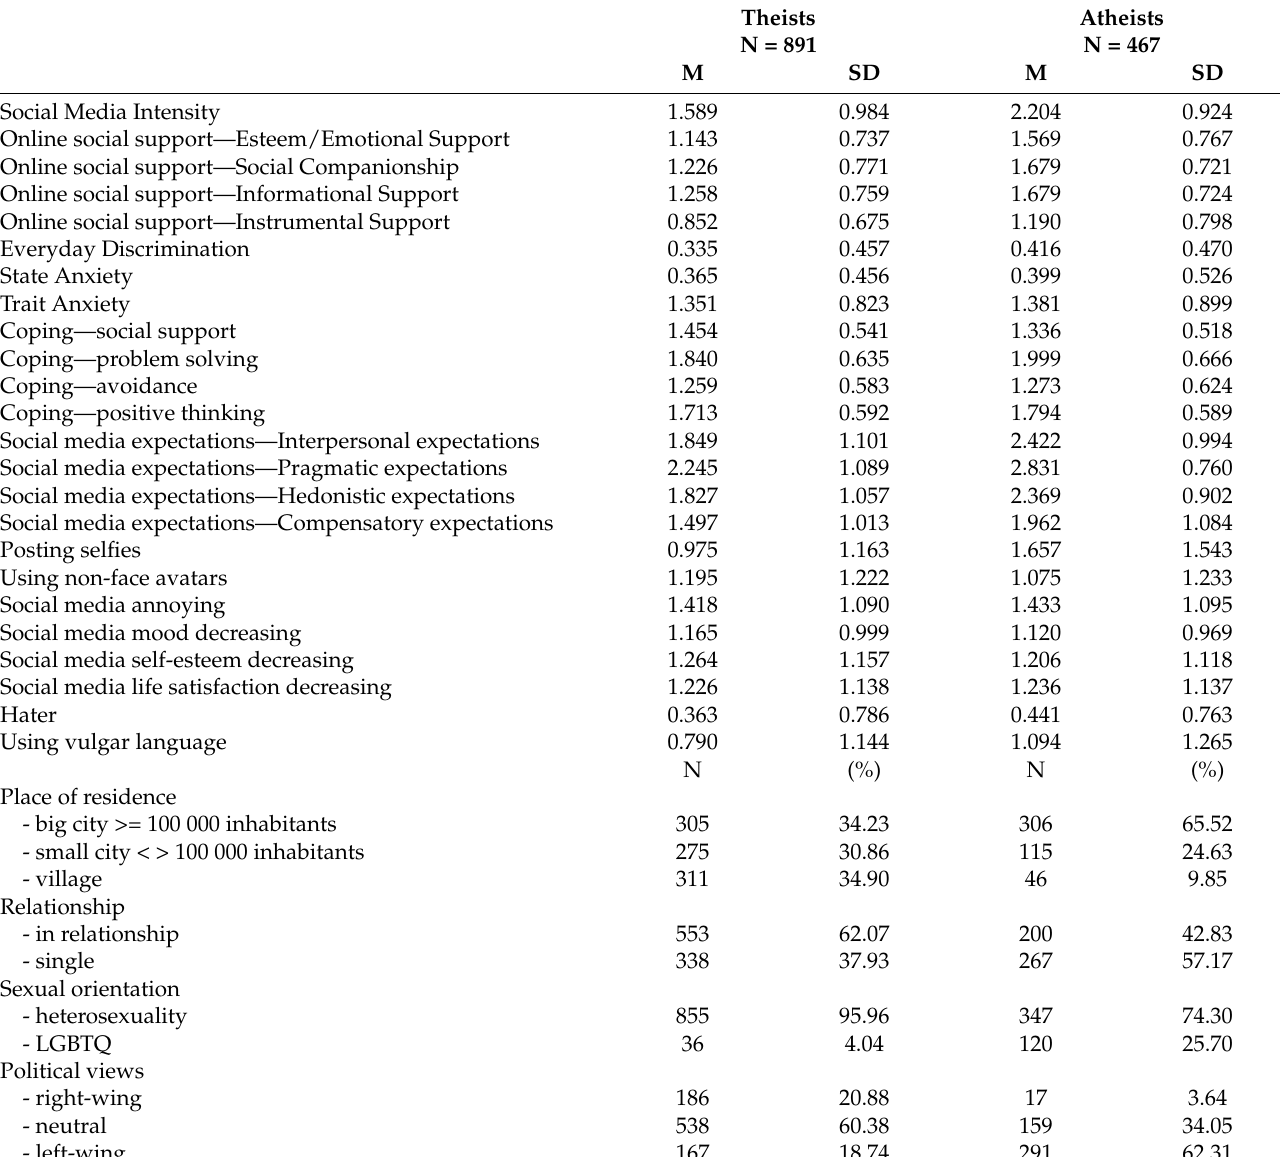
Table 4. Demographic variables: